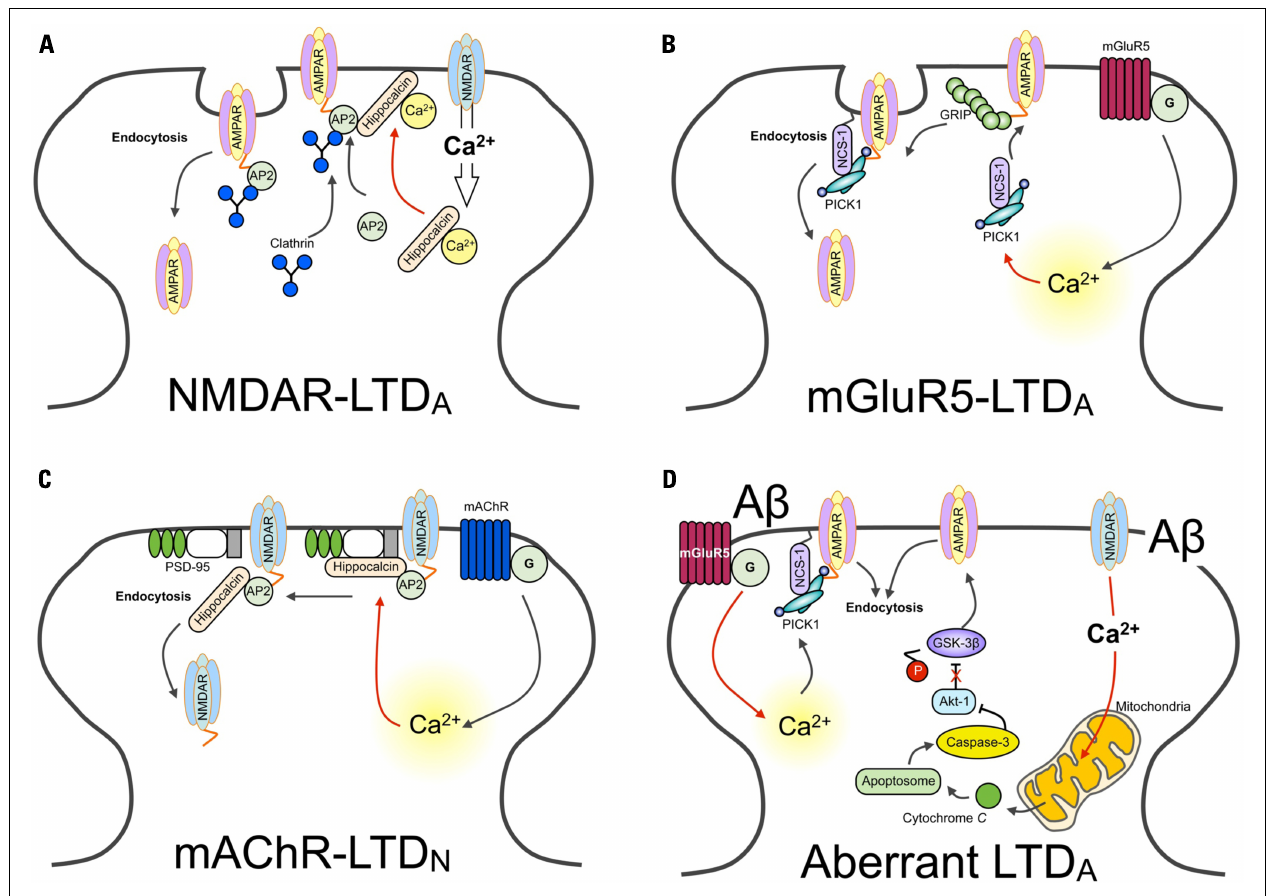
FIGURE 1 | Ca 2+ sensors and LTD. Schematic diagram showing different Ca 2 + sensors regulate distinct forms of LTD. (A) The activation of NMDARs results in Ca 2 + entry in the neuron. Ca 2 + entry through NMDARs is sensed by hippocalcin, activating the myristoyl switch and stimulating the binding to β -adaptin of the AP2 complex, resulting in its translocation to the plasma membrane. AP2 is then able to bind with the GluA2 subunit of AMPARs, recruiting clathrin. Finally, hippocalcin is displaced by clathrin, and AMPARs are internalized. (B) AMPARs are stabilized at the synapse through interactions with GRIP. Activation of the G-protein coupled metabotropic glutamate receptor (mGluR), specifically the mGluR5-isoform containing receptor, induces the release of Ca 2 + from intracellular stores. Increased levels of Ca 2 + trigger the association of PICK1 with NCS-1. PICK1 interacts with PKC. NCS-1 localizes PICK1 in close proximity with AMPARs, facilitating the PKC-mediated phosphorylation of GluA2.This releases AMPARs from the GRIP interaction, mobilizing them for synaptic removal via endocytosis. (C) Hippocalcin in bound with the SH3 domain of PSD-95.This interacts with the NMDAR subunit GluN2B.These interactions prevent the binding of AP2,